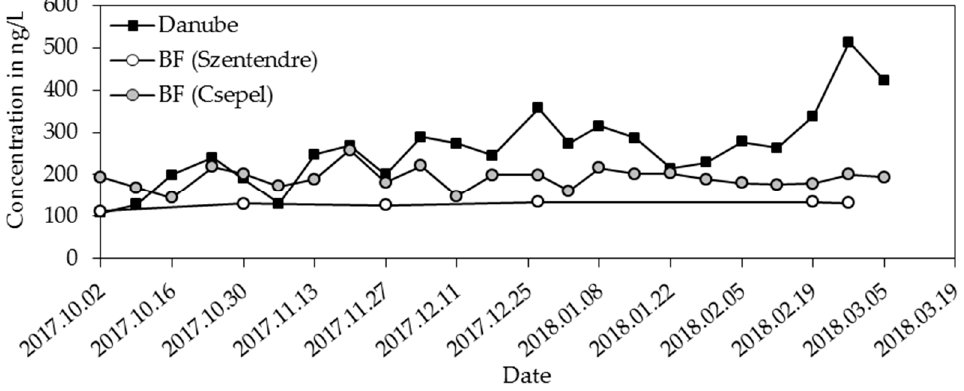
Figure 8. Seasonal fluctuation of acesulfame concentration in the Danube River water (squares) and bank filtrate (circles).